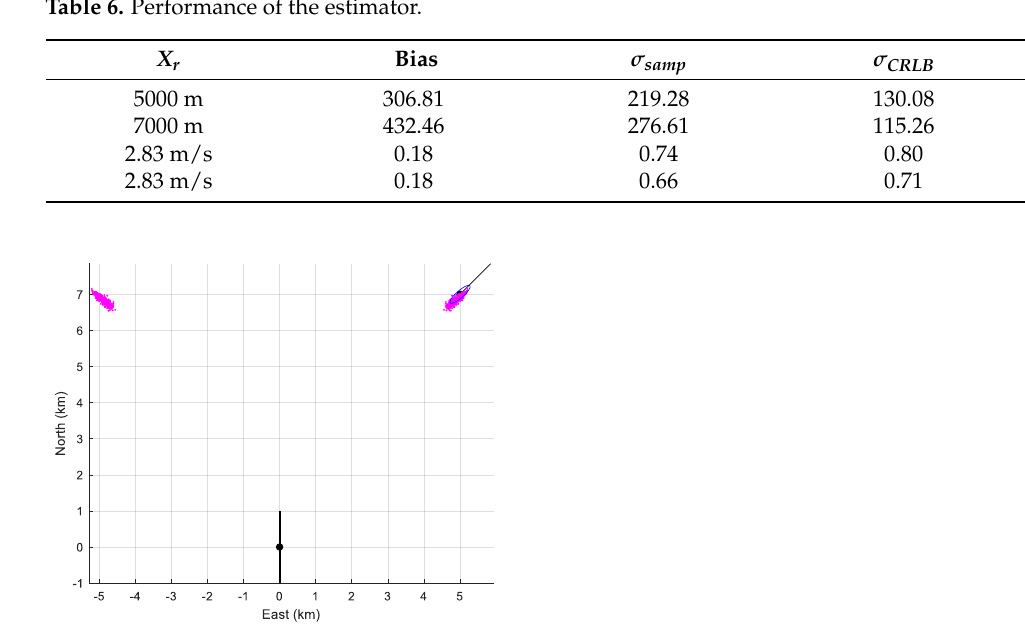
Figure 10. The location of the sensor array (in black), the cloud of the 500 estimates of the initial positions, and the 90%−confidence ellipse when 𝐷 = 4000 m, 𝑧 𝐴𝑠 = 300 m, and 𝑧 𝐴𝑠 = 100 m, together with the symmetrical cloud.